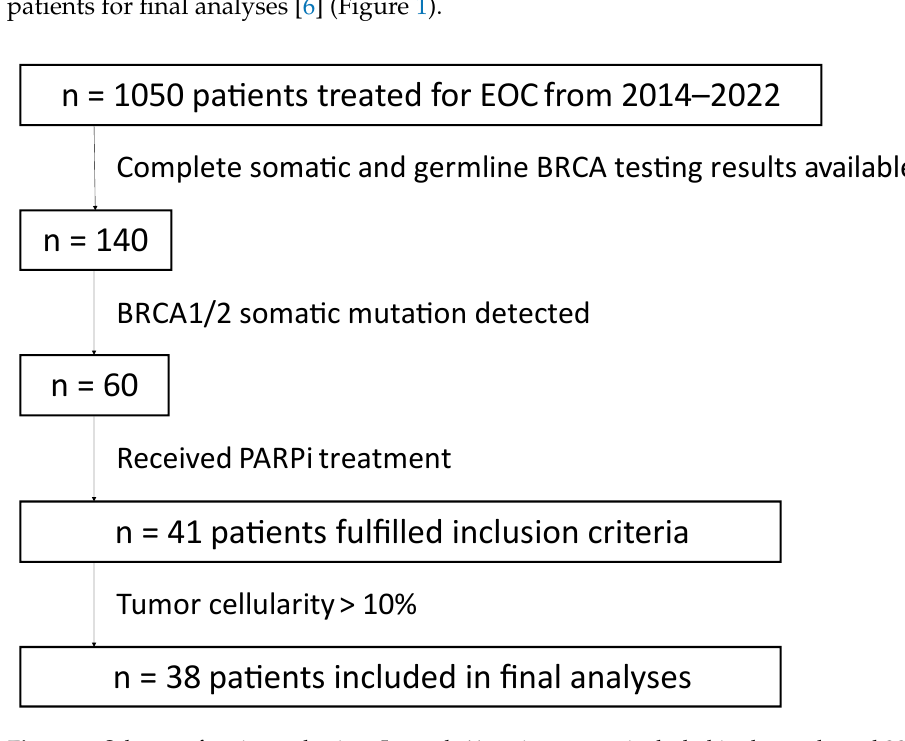
Figure 1. Scheme of patient selection. In total, 41 patients were included in the study and 38 patients were included in the final analyses.